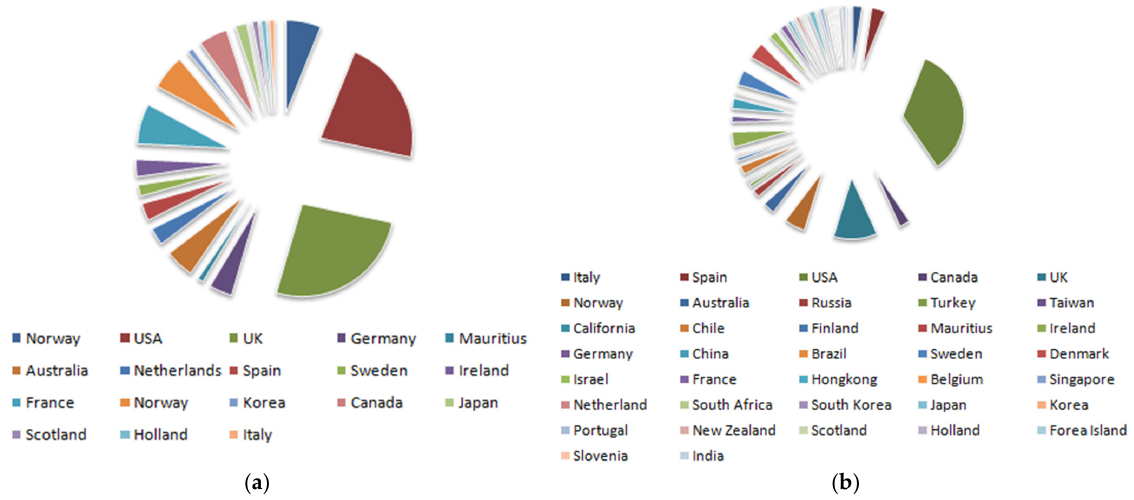
Figure 20. Distribution of companies worldwide focusing on: ( a ) tidal energy and ( b ) wave energy.